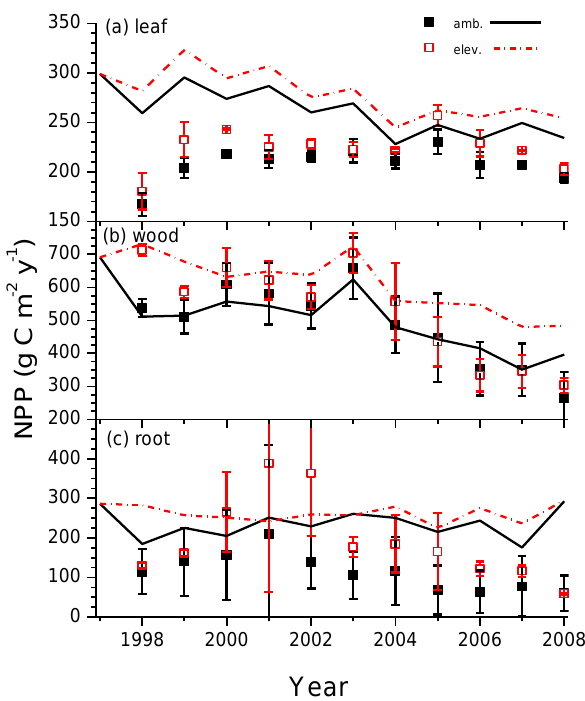
Fig. 6 Fig. 6. (a) Annual net primary productivity (NPP) and (b) gain in biomass measured (symbols) and modelled (lines) in (a) leaves, (b) wood and (c) fine + coarse roots from 1998 to 2008 under ambi- ent ( ∼ 370µmolmol − 1 ) vs. elevated ( ∼ 550µmolmol − 1 ) C a at the ORNL FACE experiment. Measured data from Norby et al. (2010) and Iversen et al. (2008), with error bars representing standard er- rors from replicated measurements ( n = 2). Root exudation (Grant, 1993) was excluded from modelled root NPP to simulate biometric measurements.